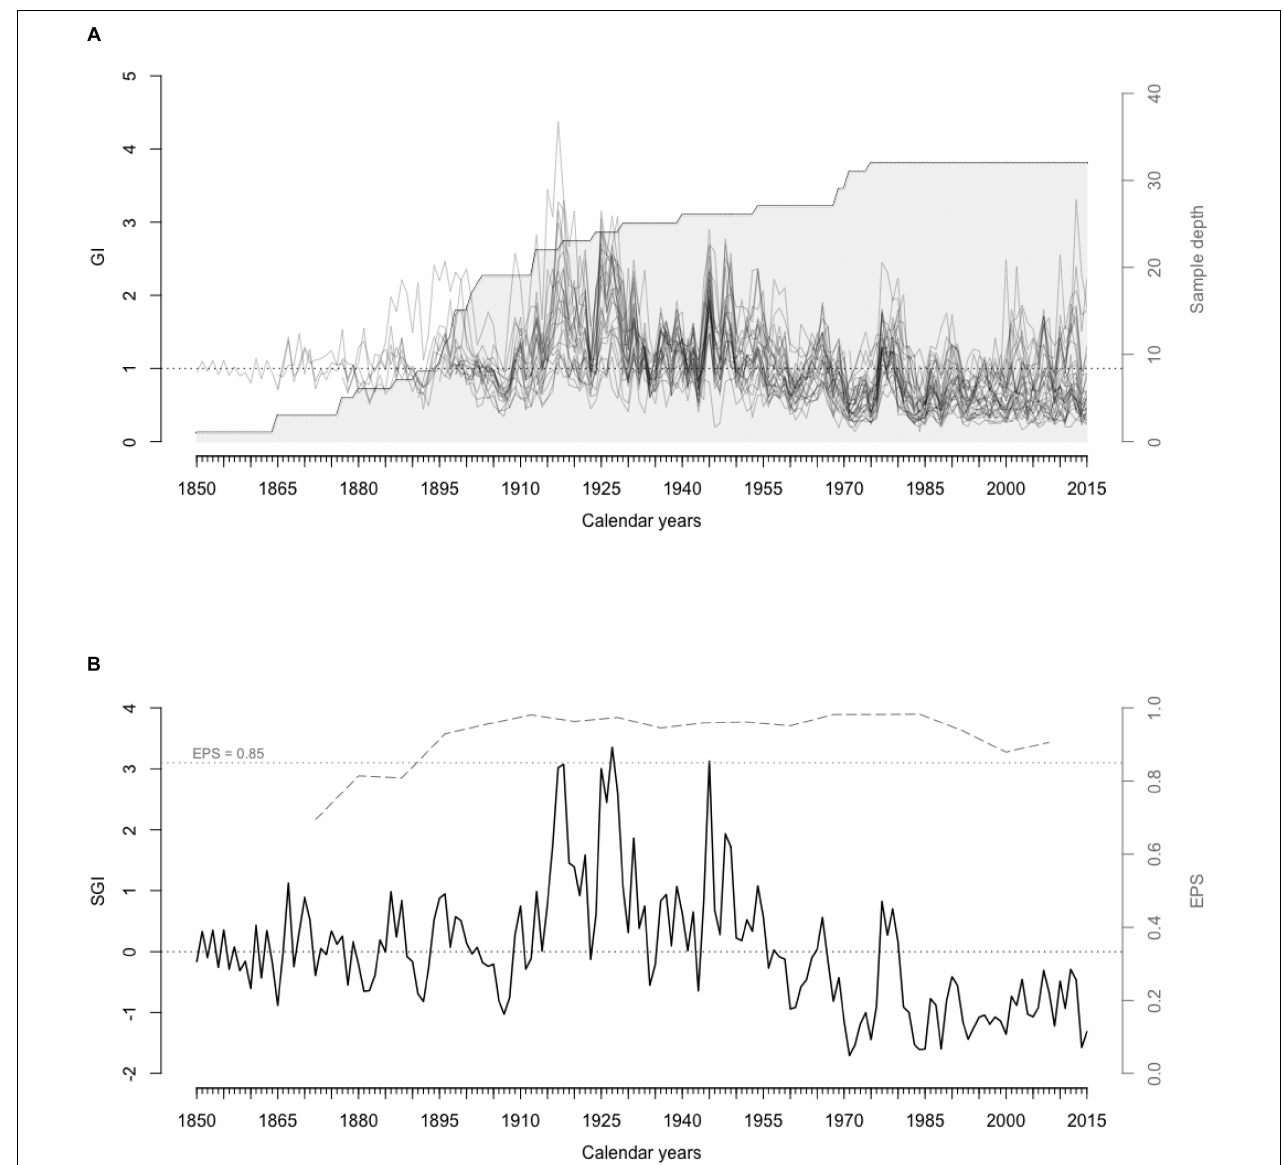
FIGURE 3 | (A) Detrended A. islandica shell growth series (GI) and number of shells in the chronology through time (Sample depth). (B) SGI master chronology (black curve) and EPS values (gray dashed curve) from the master chronology computed in 15-year running windows with arbitrary EPS threshold value 0.85 (gray dotted line) above which the master chronology is statistically